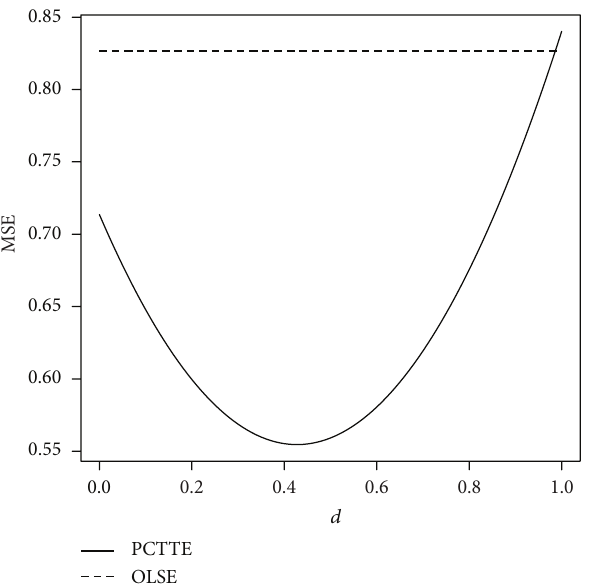
Figure 4: The MSE values of PCRE and PCTTE when 𝑘 = 0.56